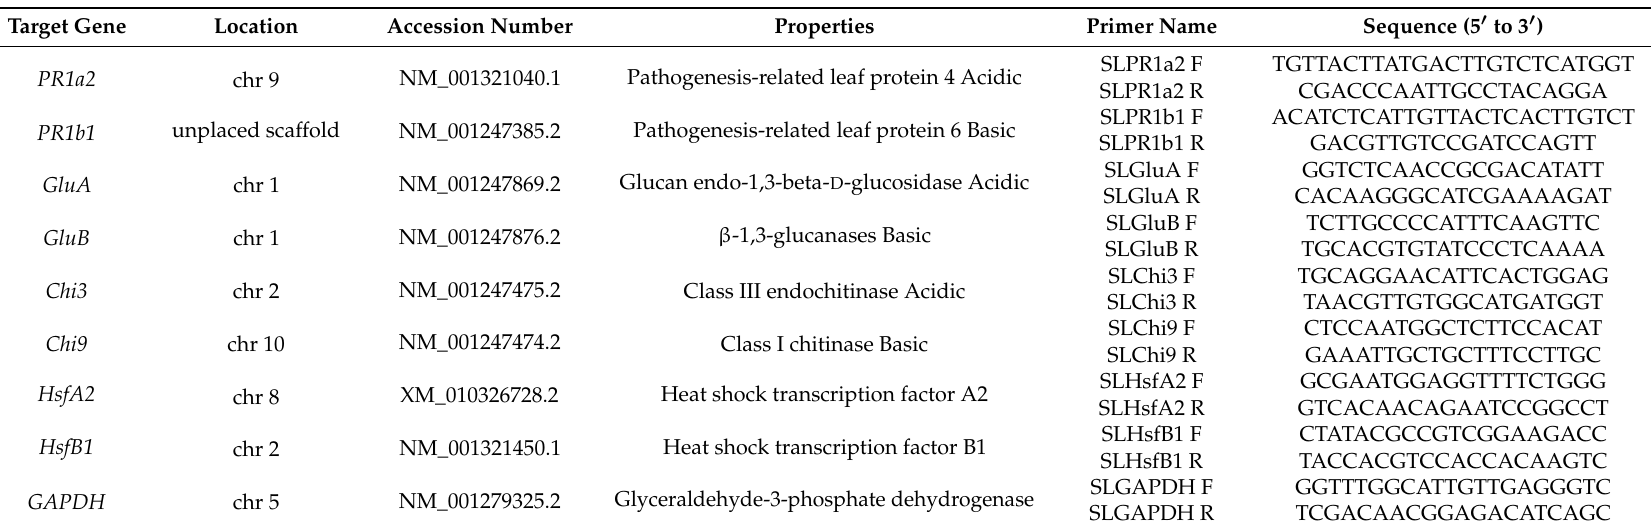
Table 1. Primers used to amplify pathogenesis-related (PR), heat shock transcription factors (Hsfs), and glyceraldehyde-3-phosphate dehydrogenase (GAPDH) genes from tomato